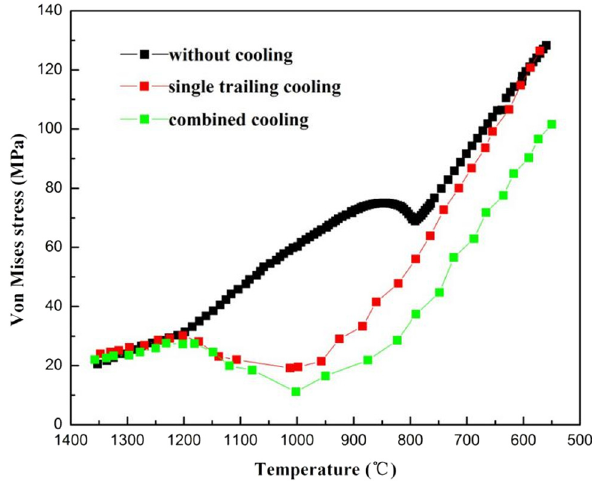
Figure 16: E ff ect of di ff erent cooling methods on the transient von Mises